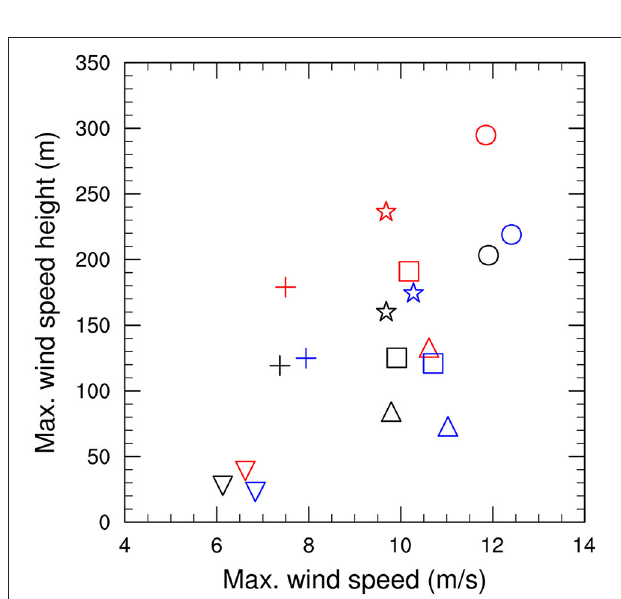
FIGURE 8 | Height of the maximum wind speed as a function of the maximum wind speed value computed from the wind speed profile of the stably stratified cases ( , S5C135; , S6C25; , S8C25, (cid:3) , S8C50; ▽ + S10C25; see Table 1 ) for the LESs (black), the SCMs with the BL89 length (red), and the SCMs with the BS length